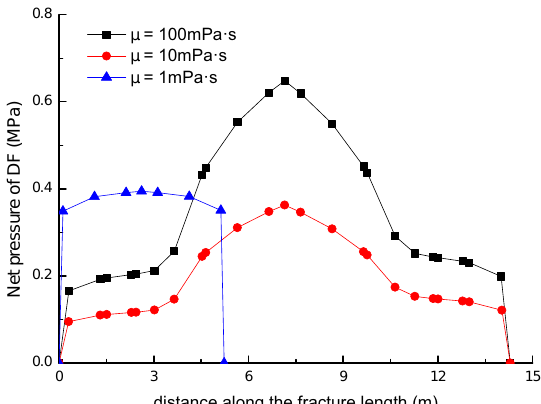
Figure 23. The net pressure curves of the DF along the fracture length at different levels of viscosity of fracturing fluid. The distance in the x -axis is along the direction from the lower part to the upper part of the DF.